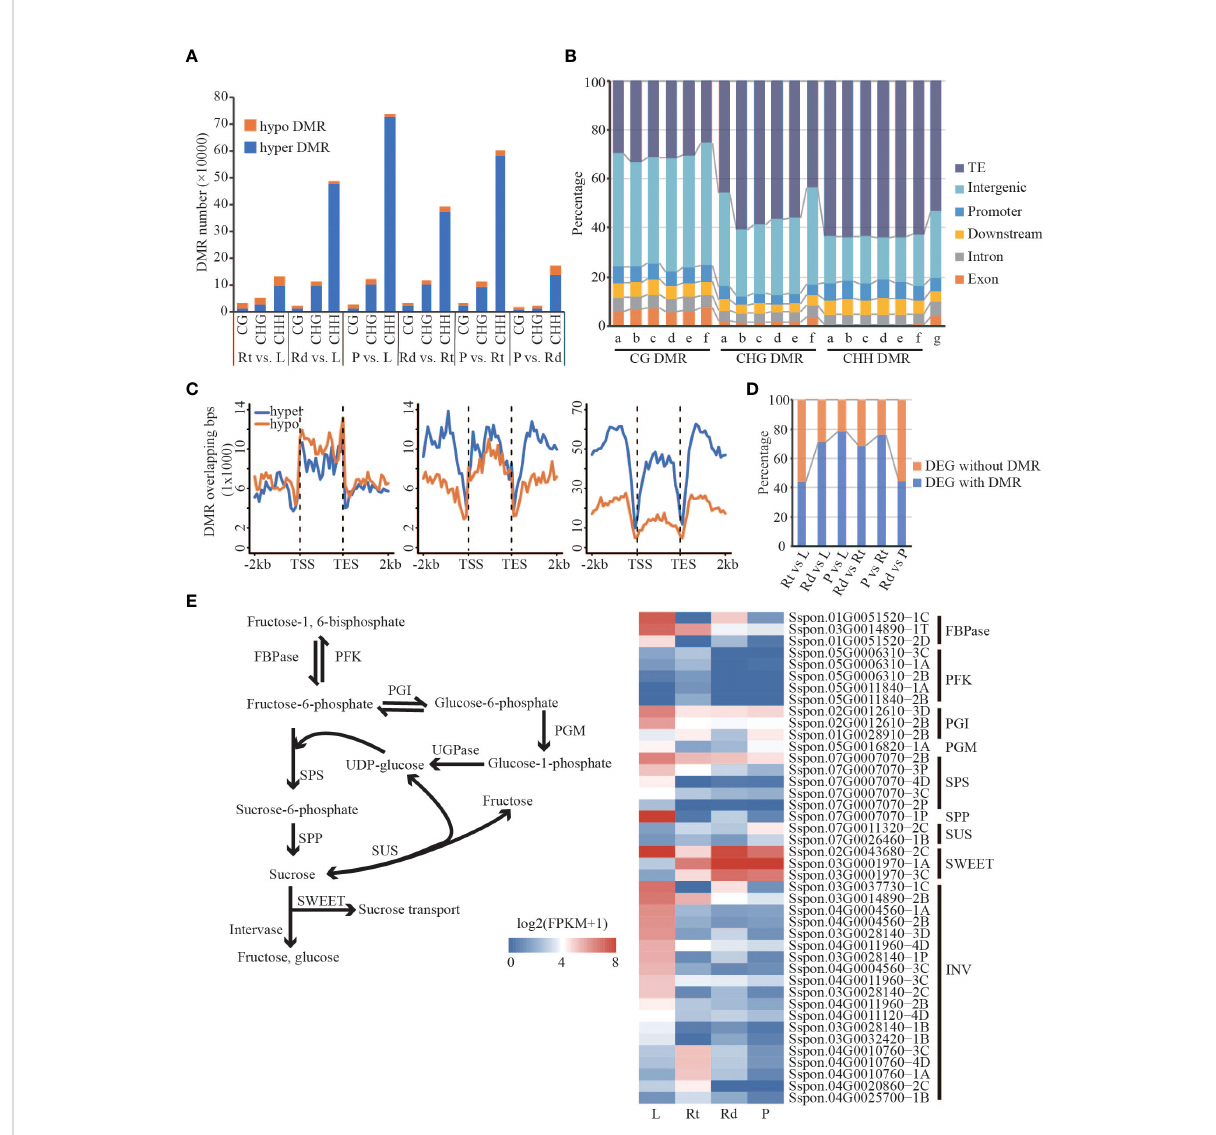
FIGURE 5 Differentially expressed genes are associated with differential methylation. (A) Barplot of hyper/hypo DMR. (B) The distribution of DMR in different regions of the genome. a, Rt vs. L; b, Rd vs. L; c, P vs. L; d, Rd vs. Rt; e, P vs. L; f, P vs. Rd; g, genome. (C) Distribution of DMR in the gene body and fl anking region (Rt vs. L). (D) The proportion of DEG with DMR/without DMR. (E) Sucrose synthesis and hydrolysis pathways and the expression pattern of DMR-DEGs related to sucrose synthesis and hydrolysis pathways. FBPase, fructose-1,6-bisphosphatase; PFK, phosphofructokinase; PGI, phosphoglucose; PGM, phosphoglucomutase; SPS, sucrose phosphate synthase; SPP, sucrose-6F-phosphate phosphohydrolase; SUS, sucrose synthase; SWEET, sugars will eventually be exported transporters; INV, invertase; L, leaf; Rt, root; Rd, rind; P, pith; DEG, differentially expressed gene; DMR, differentially methylated